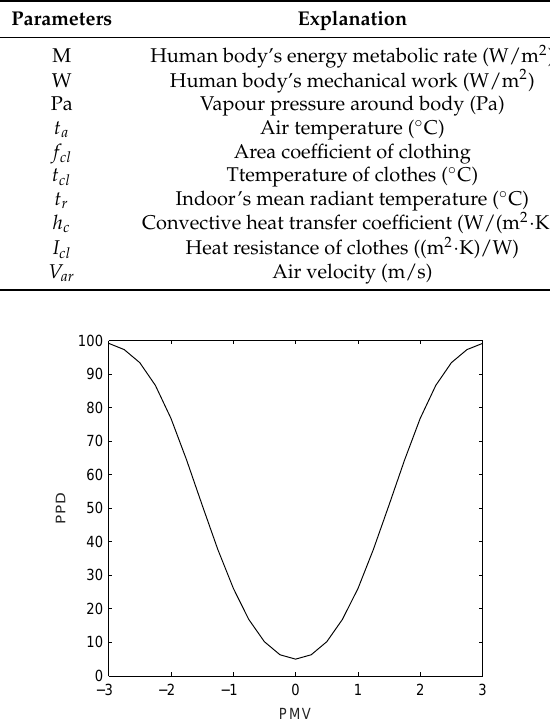
Figure 3. The relationship between PPD and